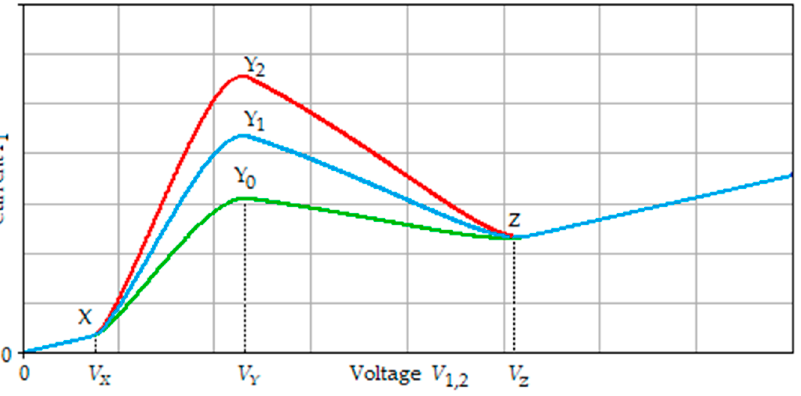
Figure 2. Current-voltage characteristics of a two-terminal NDR circuit with multiple-output current mirror; m = 0—green curve, m = 1—blue curve, m = 2—red curve.